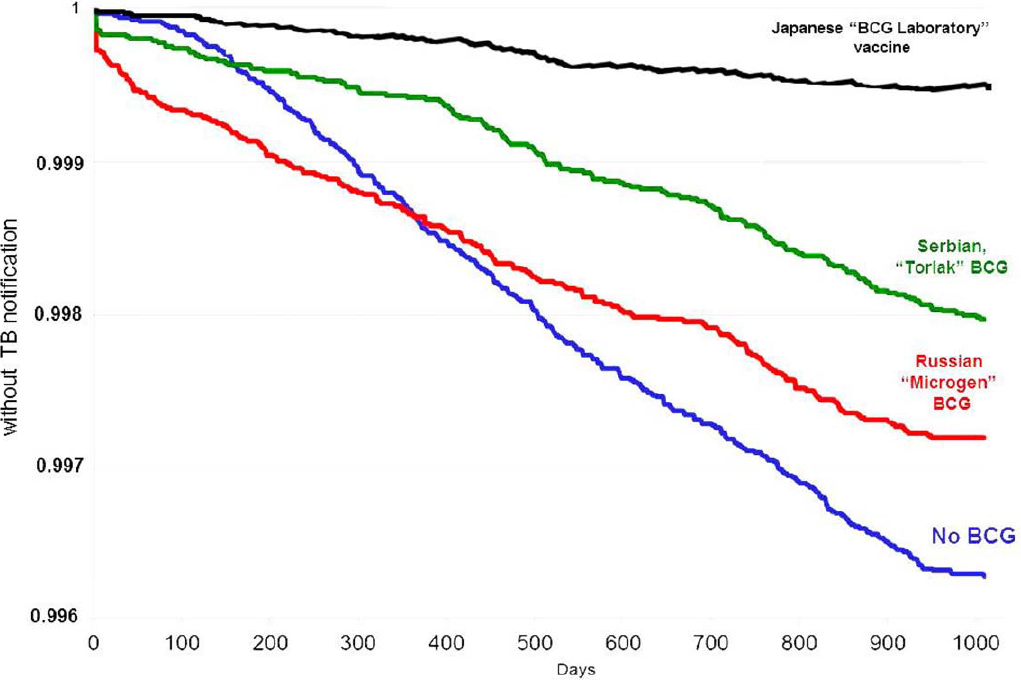
Figure 3. Survivor curve person-year analyses for reported incidence of active TB among different BCG vaccinated and non- vaccinated birth cohorts, Kazakhstan, 2002–2008.